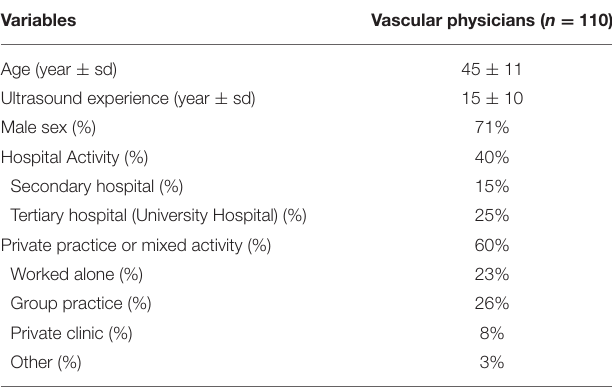
TABLE 1 | Epidemiological characteristics of French vascular